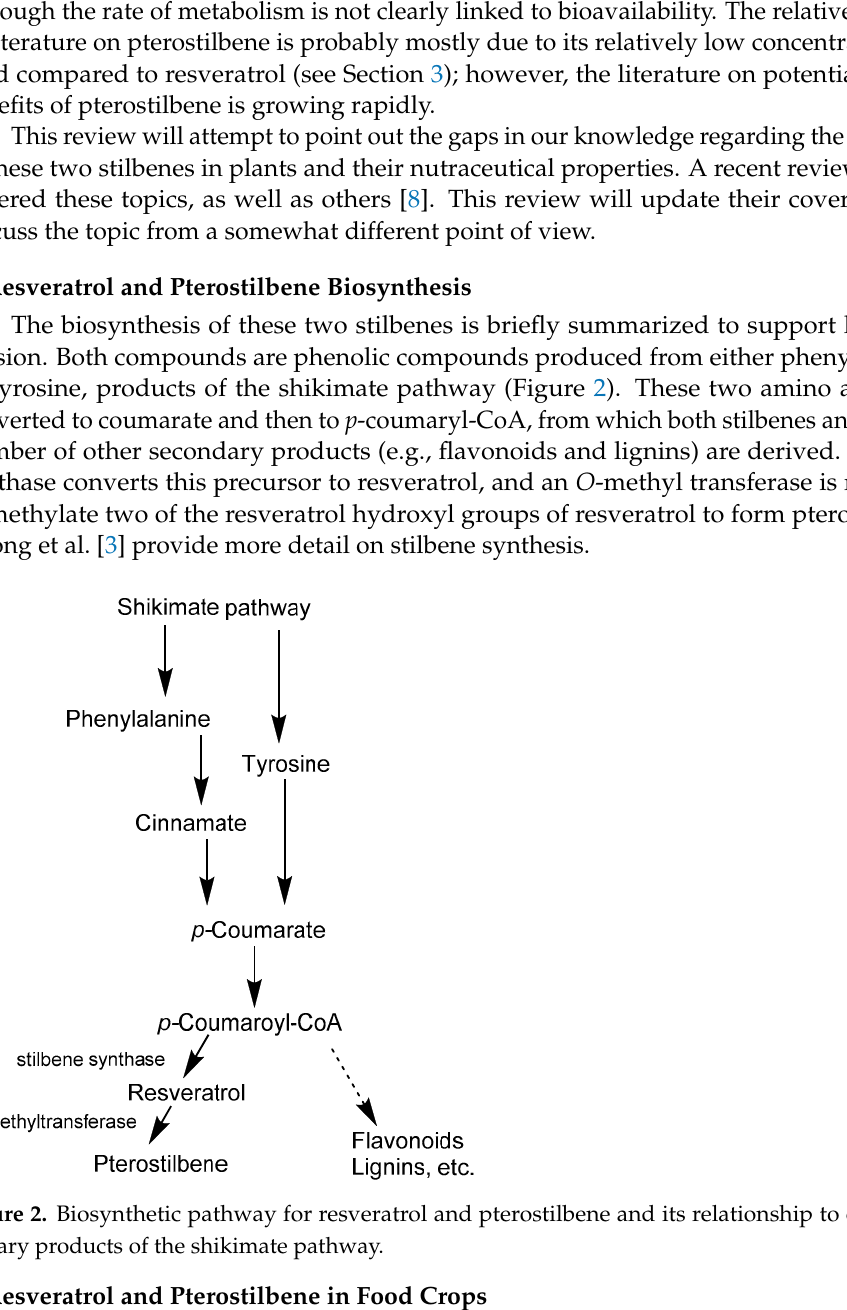
Table 1. Resveratrol and/or pterostilbene concentrations in some food crops and foods derived from these crops. All values are µg/g dry wt. A dash (-) means that this value was not provided. Crop/Food Resveratrol Pterostilbene References Peanut ( Arachis hypogaea )